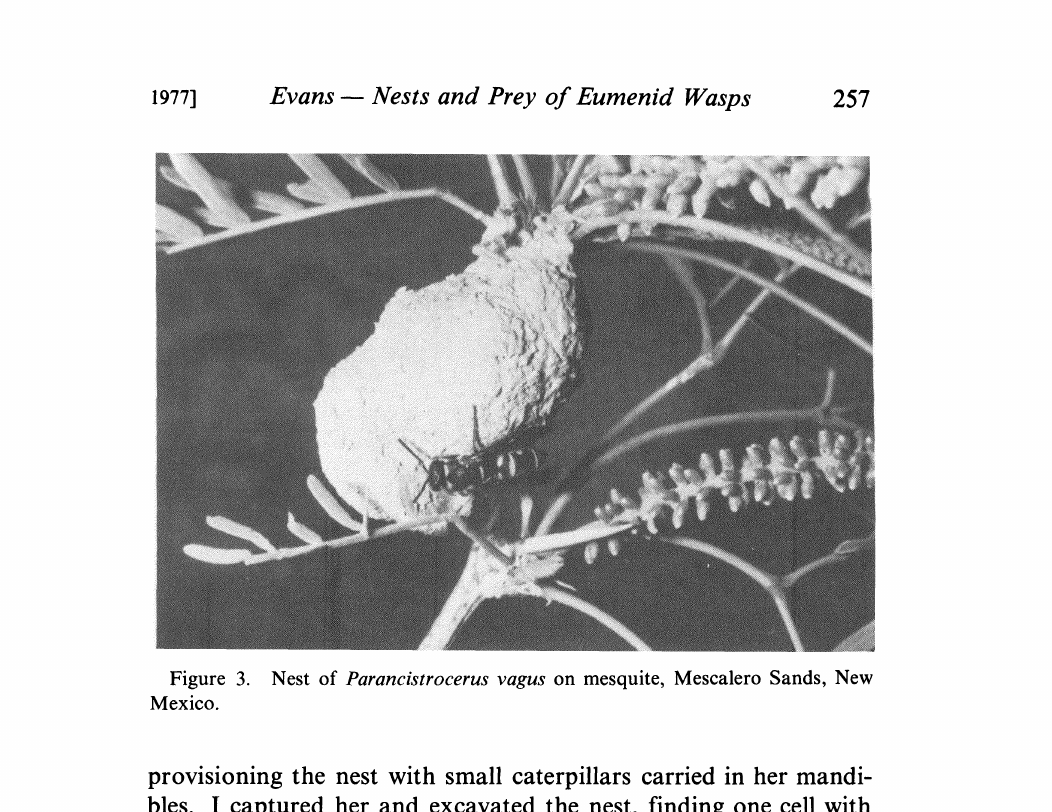
Figure 3. Nest of Parancistroeerus vagus on mesquite, Mescalero Sands, New